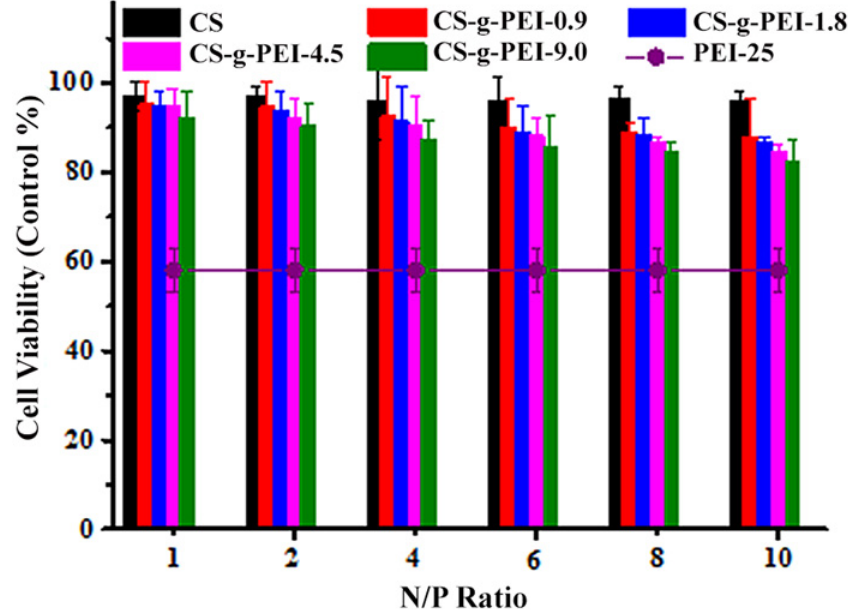
Fig 10. Viability of HEp-2 cells after incubation with CS/pDNA and CS- g -PEI/pDNA polyplexes for 24 h at various N/P ratios. Cells with no treatment used as control; PEI-25 as negative